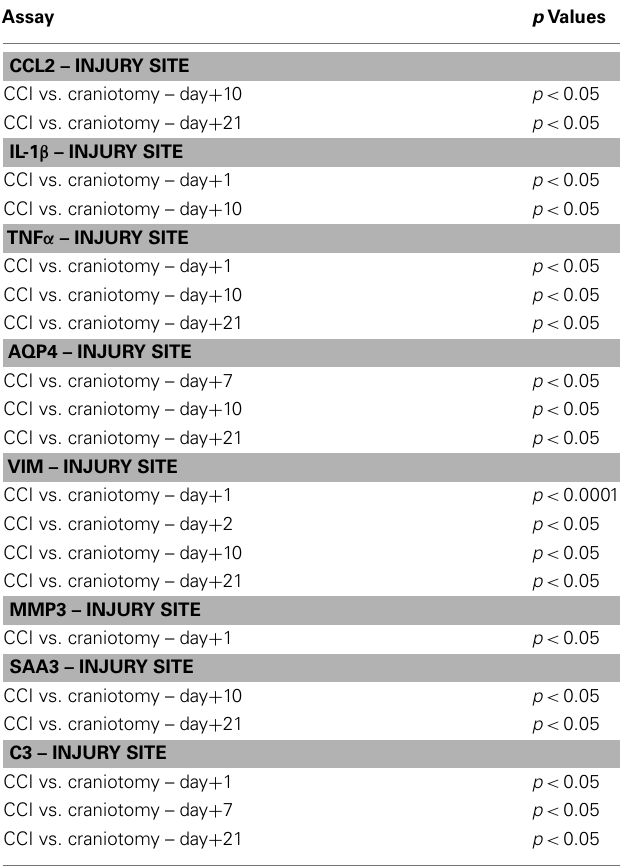
Table 4 | Statistically significant changes in gene